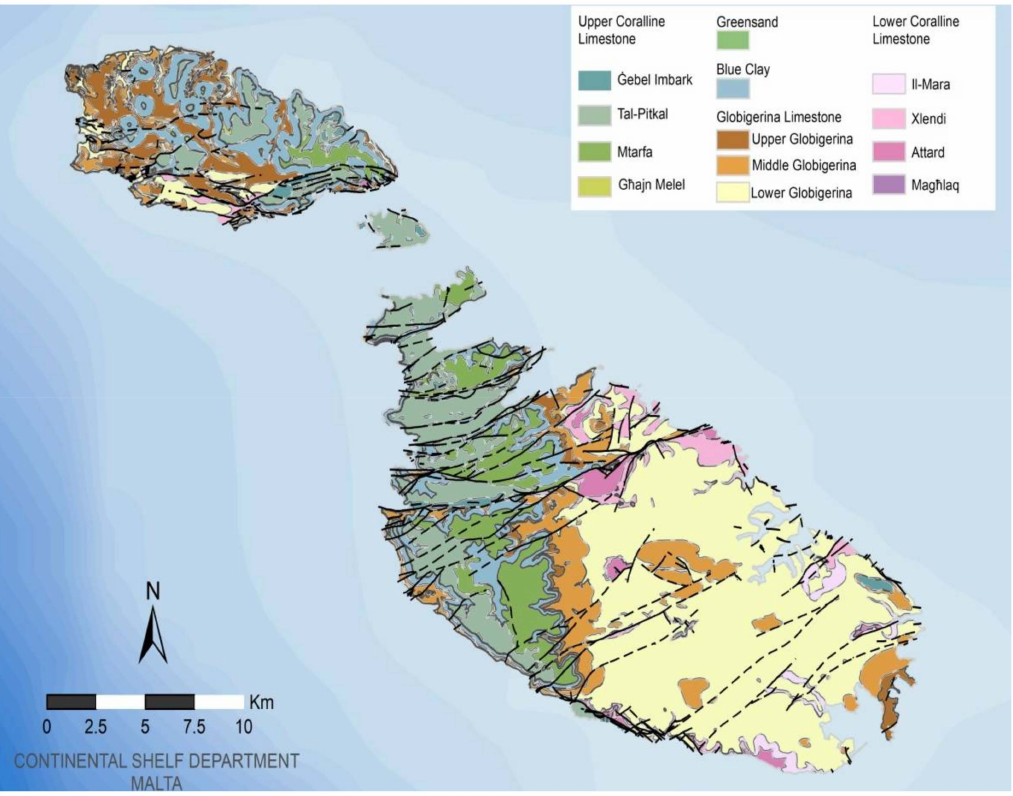
Figure 3. Geological map of the Maltese Islands